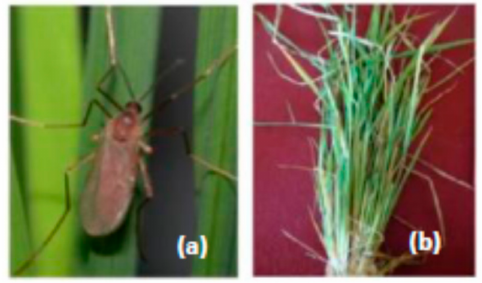
Figure 1. ( a ) Adult gall midge, Orseolia oryzae . ( b ) Symptoms of damage by gall